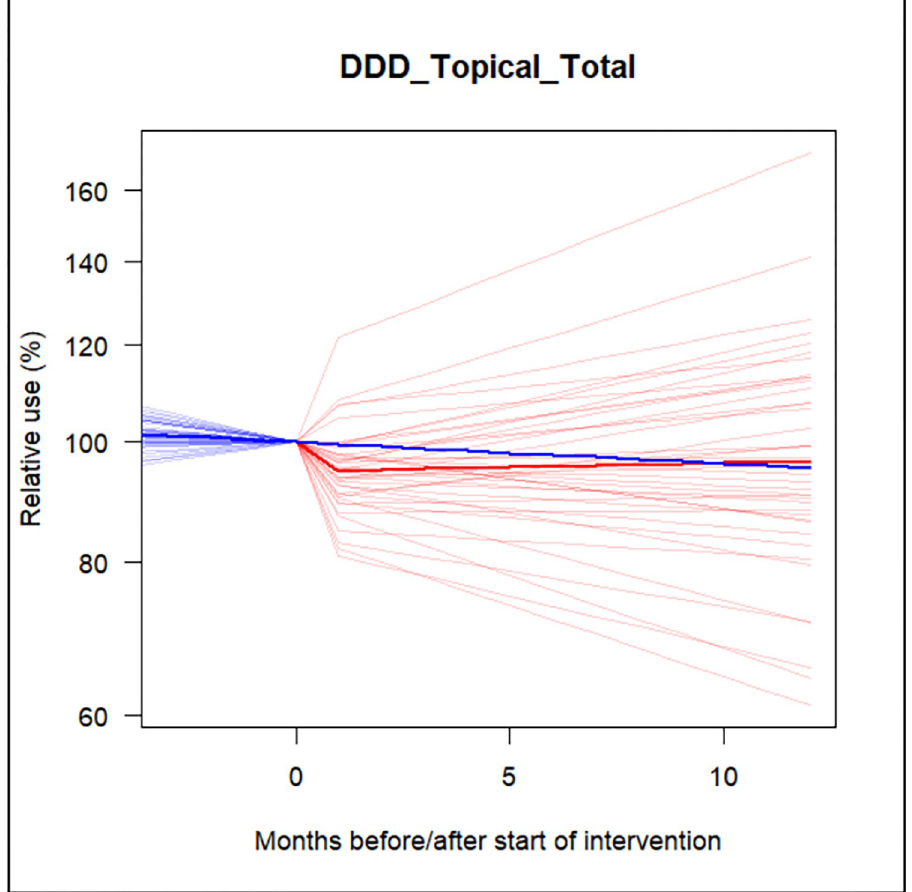
Fig 2. Average (bold lines) and clinic-specific (thin lines) of total topical antimicrobial use. The blue line indicates the trend if no intervention had occurred. The red lines indicate the effects of the intervention. This is based on the estimation of the model of the trend, drop and slope regarding total topical antimicrobial